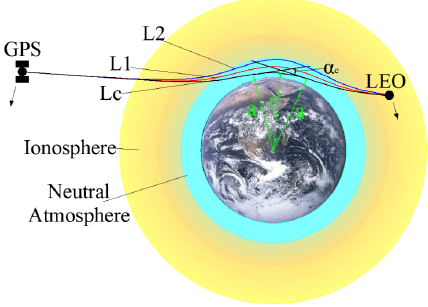
Figure 1. Radio occultation geometry illustrating the separated L1 and L2 signal paths and the ionosphere-corrected ray path L c ; α c is the ionosphere-corrected bending angle, a is the impact parameter and r is the radius from the Earth’s center of curvature to the tangent point of the GPS–LEO signal